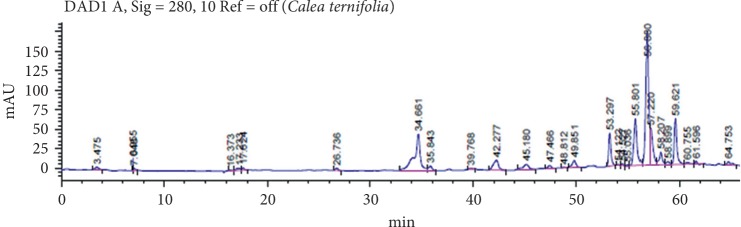
Chromatogram of the total extract of C. ternifolia by HPLC at a concentration of 1000 μgmL−1, in a proportion 70 : 30 (methanol: water). The identification of compounds was carried out with the comparison of retention times of the standards.